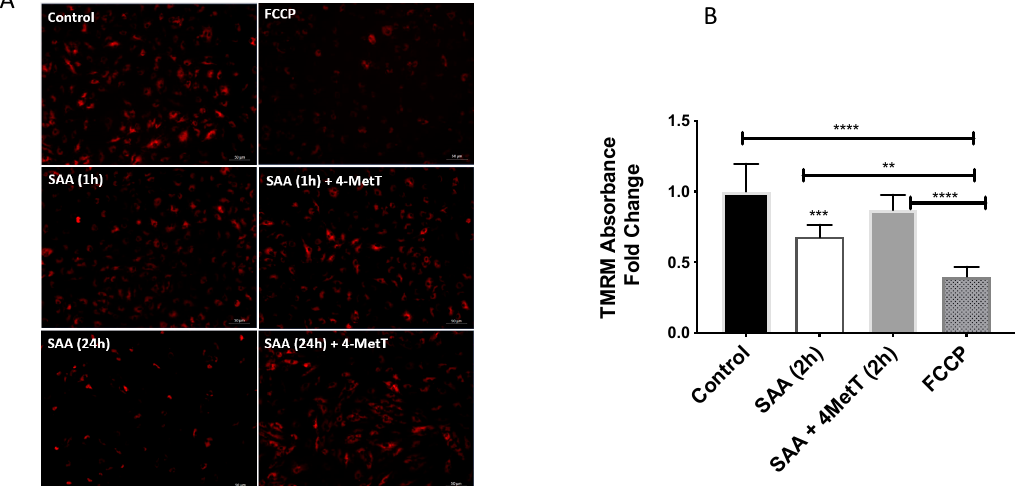
Figure 7. Effect of SAA and 4-MetT on mitochondrial membrane potential ( Δψ m) in cultured primary HAEC. TMRM was used to provide a measure of Δψ m (see Methods Section). FCCP was used as a control to depolarise the mitochondrial membrane. ( A ). Cells were treated with 10 µg/mL SAA for either 2 or 24 h with or without 4-MetT pre-treatment for 24 h. Images captured via fluorescent microscopy at ×10 magnification using an appropriate filter set. Images are representative of X fields of view from n = 3 Control, FCCP; n = 4 SAA (2 h); n = 5 SAA (2 h) + 4-MetT, SAA (24 h), SAA (24 h) + 4-MetT independent experiments (scale bar 50µm). ( B ). In a repeat independent study signal intensity was measured at 548/574 nm absorbance/emission respectively after 2 h incubation with respective treatments using an Infinite ® M200 PRO Plate reader (Tecan, Männedorf, Germany). Data represent mean ± SD, n = 6 independent biological replicates. All data was normalised against corresponding total cellular protein and expressed as relative fold change compared to the control (arbitrability assigned a value of 1). ** p = 0.003; *** p = 0.0006; **** p < 0.0001.